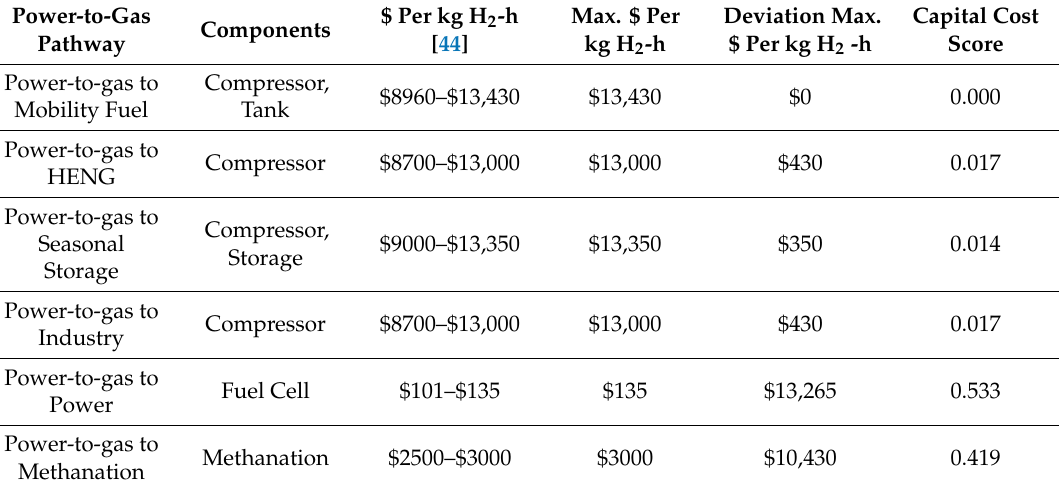
Table 9. Capital Costs of Hydrogen Storage and Handling for power-to-gas Pathways.